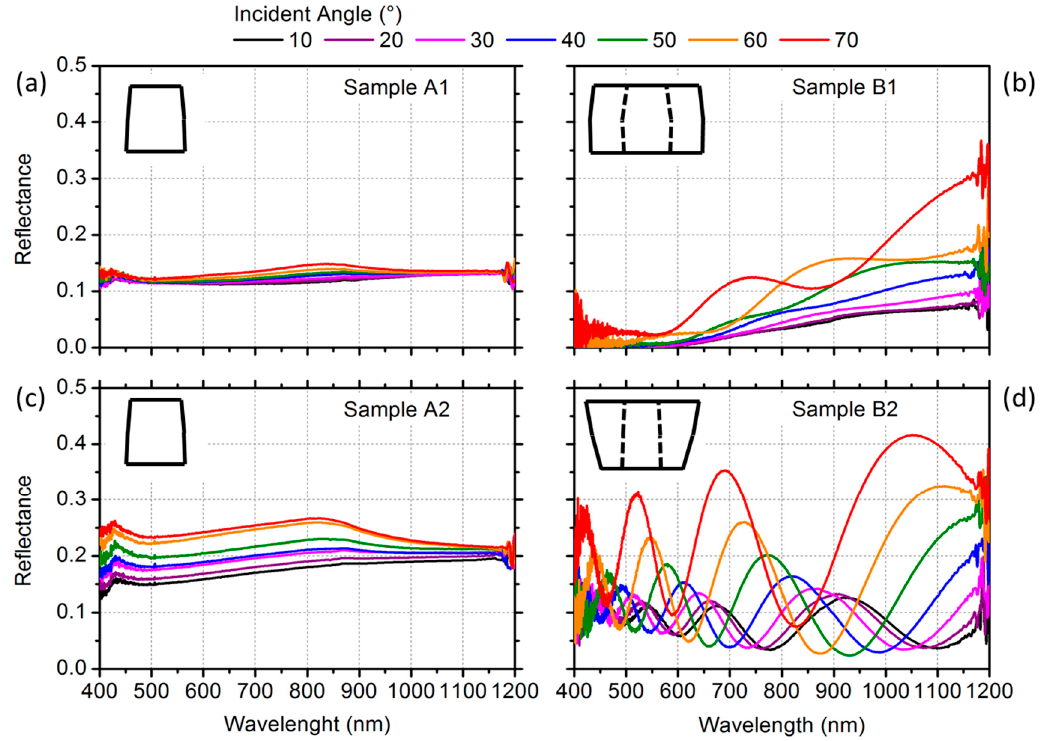
Figure 3. Reflectance experimental results for transverse-electric polarized incident light. The specular reflectance measured in ( a , c ) homogeneous GaAs NWs (samples A1 and A2); ( b ) nontapered GaAs–AlGaAs core–shell (C–S) NWs (sample B1); and ( d ) tapered GaAs–AlGaAs C–S NWs (sample B2).